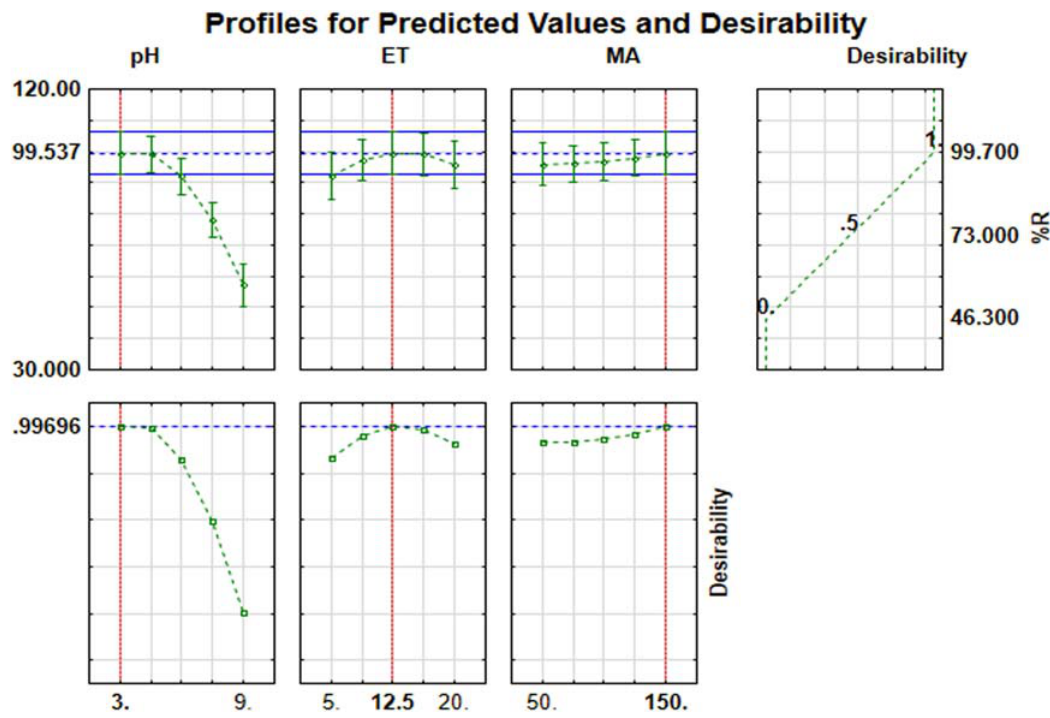
Figure 9: Pro fi le for the predicted values and DF for the percentage recovery of